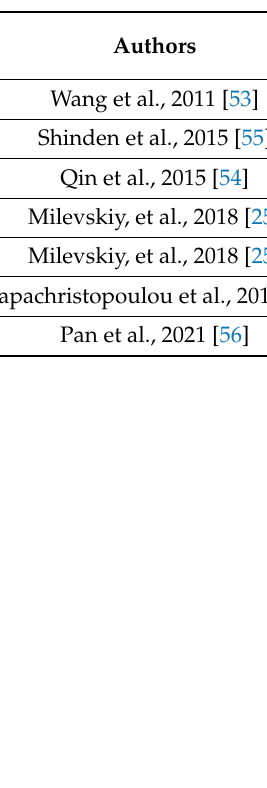
Table 1. Positive (pos) or negative (neg) correlation of miR-29b in invasive breast tumor tissues with tumor